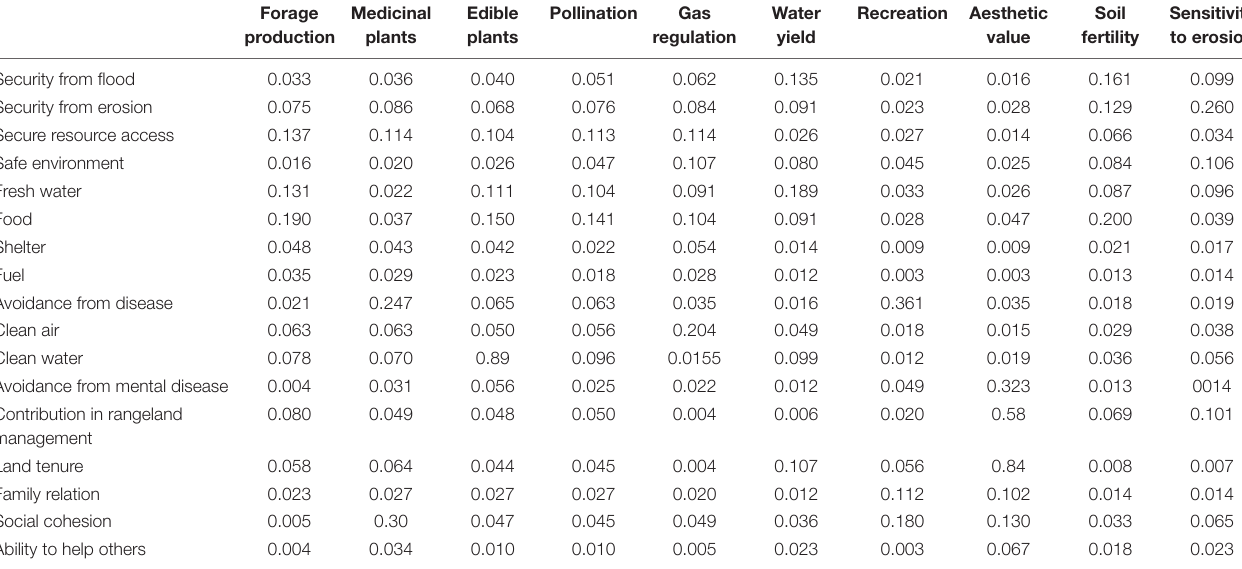
TABLE 3 | Relative weights of the well-being indices for each ecosystem